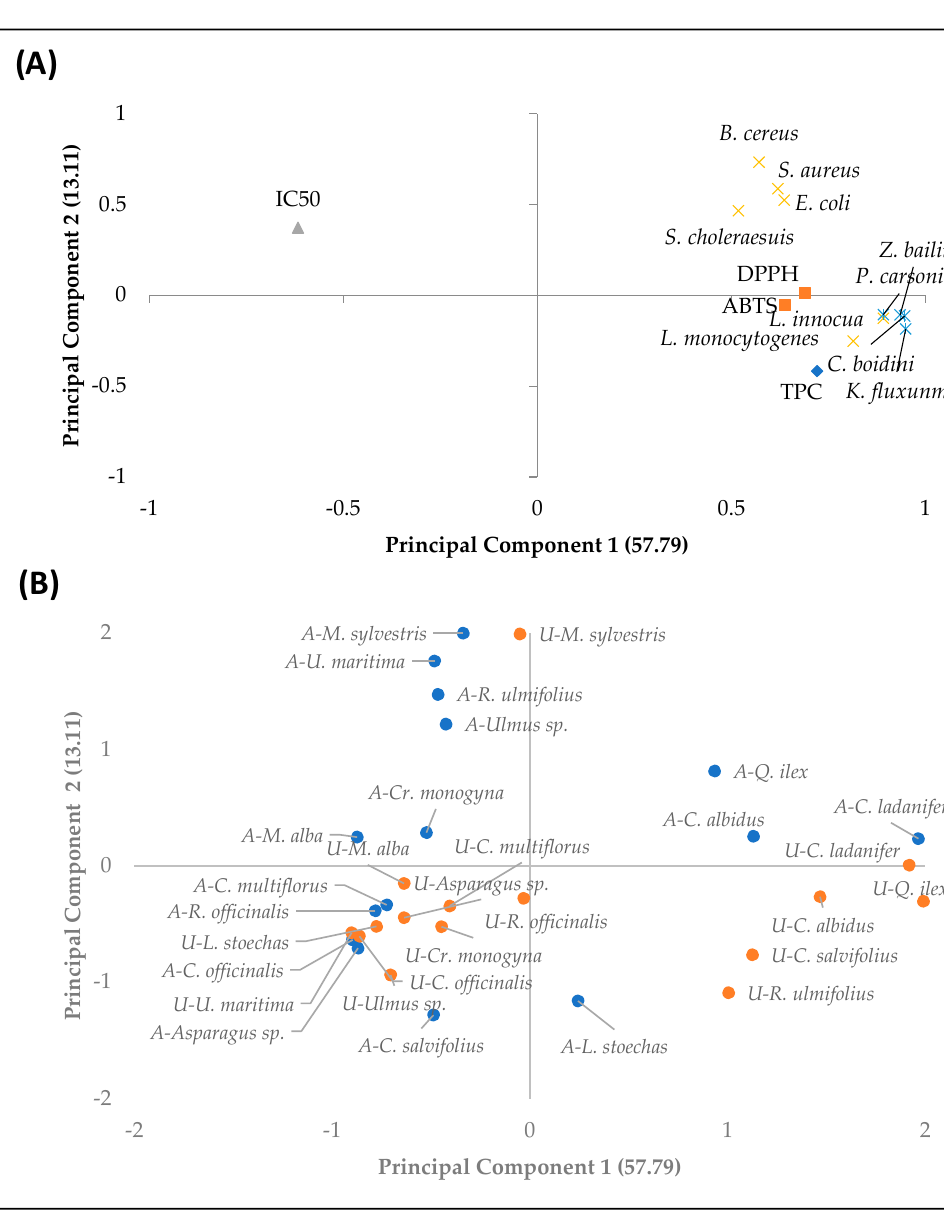
Figure 1. Principal component analysis of the parameters analysed in the extracts from different plants extracted by agitation (A) and ultrasound (U). Loading plot ( A ). TPC: total phenolic compounds; DPPH and ABTS: antioxidant activity of extracts; IC50: extract concentration ( µ g/mL) required to reduce 50% of ACE; B. cereus , S. aureus , E. coli , S. choleraesuis , L. innocua and L. monocytogenes : antimicrobial activity against each of the bacteria; Z. bailii , P. carsonii , C. boidinii and K. fluxuum : antimicrobial activity against each of the yeasts. Score plot ( B ). Plant extracts extracted by agitation (blue); plant extracts extracted by ultrasound